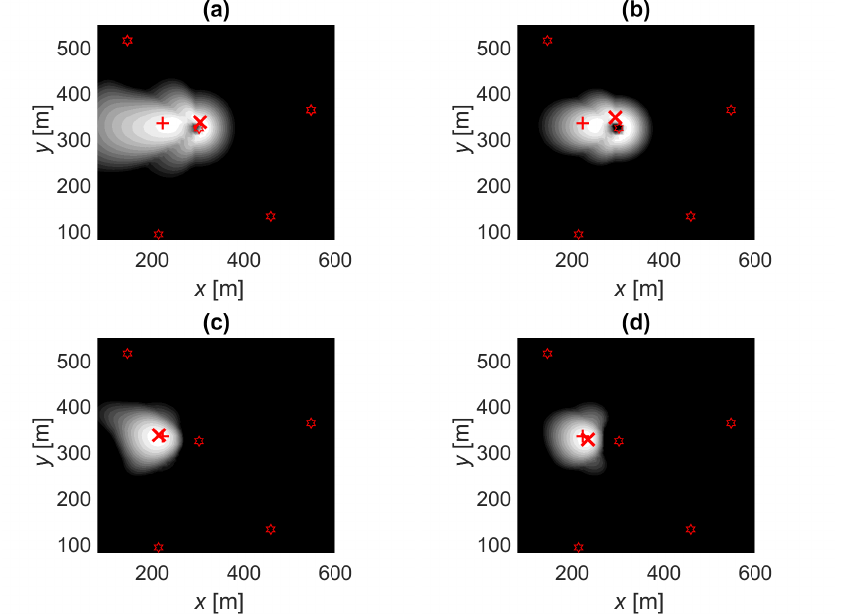
Figure 6. Likelihood function illustrations: true location (+), position estimate ( × ), base stations (BSs; stars), contact with three BSs with directive antennas ( N = 8) at ( x BS , y BS ) = (302,324), (547,363), and (146,516). White is likely, gray is possible, and black is an unlikely location.( a ) OLS-OPT: ordinary least squares fitting and trilateration positioning. ( b ) MLE-OPT: Tobit MLE fitting and the ordinary trilateration positioning. ( c ) OLS-MLE: ordinary least squares fitting and the Tobit MLE positioning. ( d ) MLE-MLE: Tobit MLE fitting and the Tobit MLE